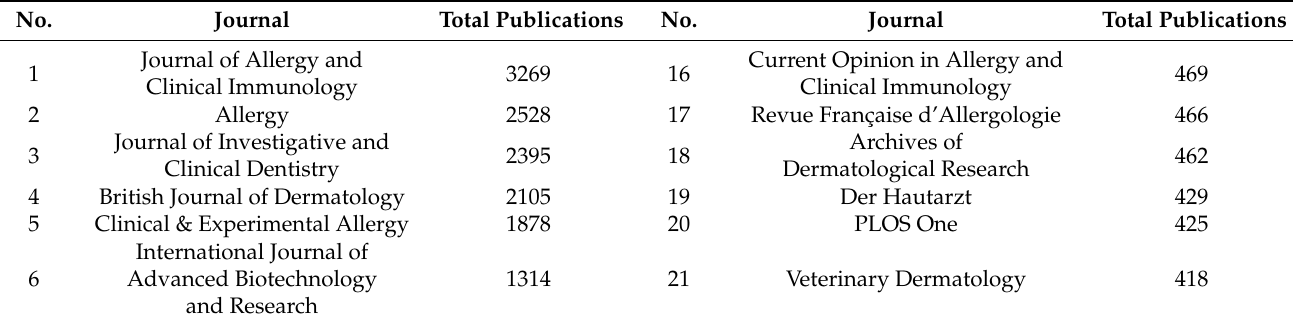
Table 4. The top 30 journals in terms of atopic dermatitis publications over the past 30